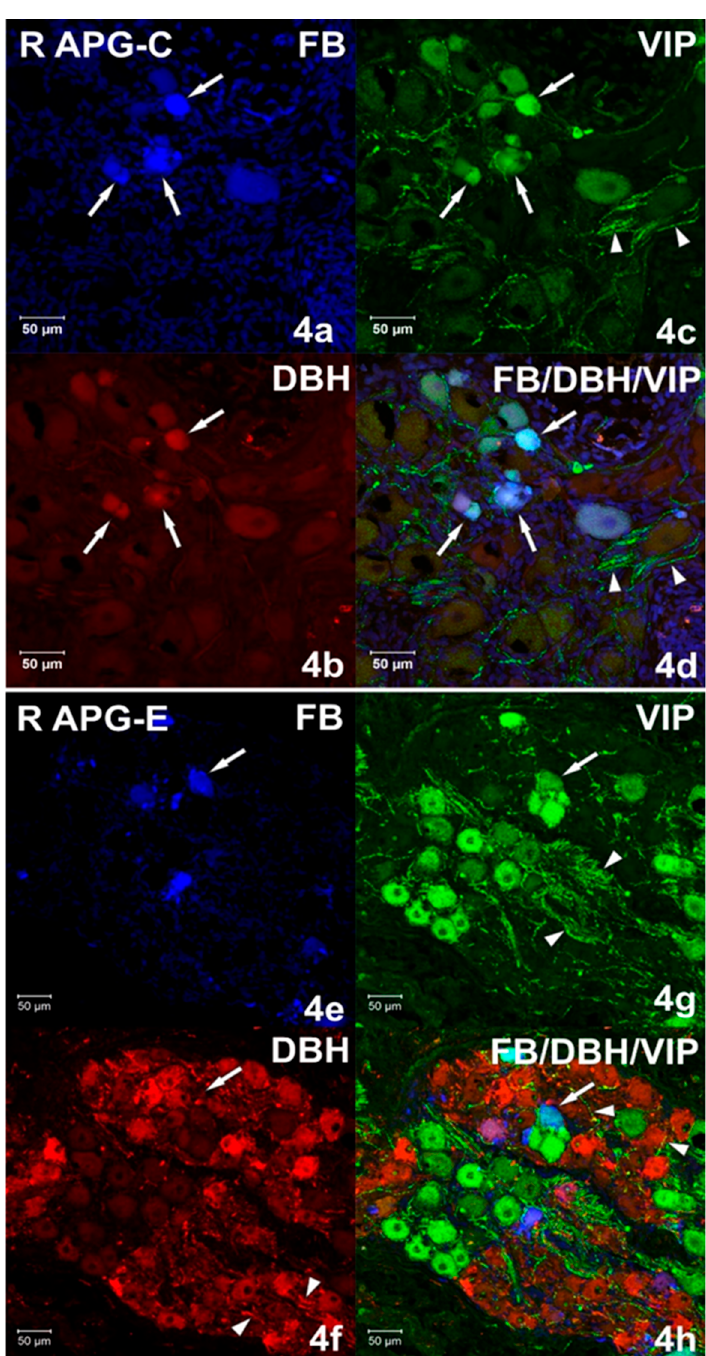
Figure 4. ( a – d ) Confocal laser scanning microscope images showing a section of the right (R) APG from the control (C) group. Arrows indicate FB+ neurons ( a ) immunoreactive simultaneously ( d ) against vasoactive intestinal polypeptide (VIP) ( c ) and dopamine-B-hydroxylase (DBH) ( b ). A small number of VIP-IR ( c , d ) nerve fibers are marked with arrowheads. The images were taken from blue, green and red fluorescent channels. Blue, green and red channels were digitally superimposed ( d ). Scale bar = 50 µm. ( e – h ) Confocal laser scanning microscope images showing a section of the right (R) APG from the experimental (E) group. The arrow indicates the FB+ neuron ( e ) immunoreactive with VIP ( g ) but not containing DBH ( f ). A large amount of DBH-IR ( f ) and VIP-IR ( g ) fibers and single DBH/VIP -IR (h) fibers marked with arrowheads. The images were taken from blue, green and red fluorescent channels. Blue, green and red channels were digitally superimposed ( h ). Scale bar = 50 µm.